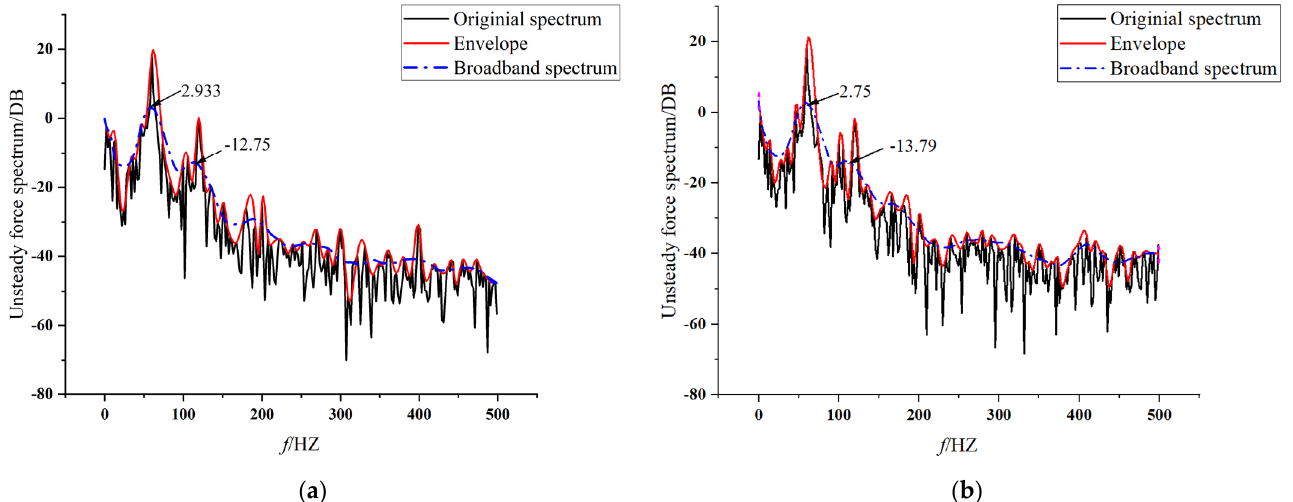
Figure 21. Broadband spectrum of unsteady forces for pump-jet propulsion system: ( a ) broadband spectrum of unsteady forces for parent pump-jet propulsion system; ( b ) broadband spectrum of unsteady forces for optimized pump-jet propulsion system.